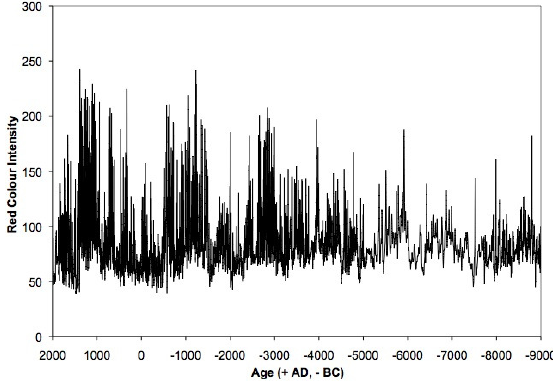
Fig. 5. El Nino proxy reconstruction from Laguna Pallcacocha, Ecuador. High red color intensity indicates an El Nino event. At about 1500BC a series of strong El Nino events begins that lasts for centuries (adapted from Moy et al.,